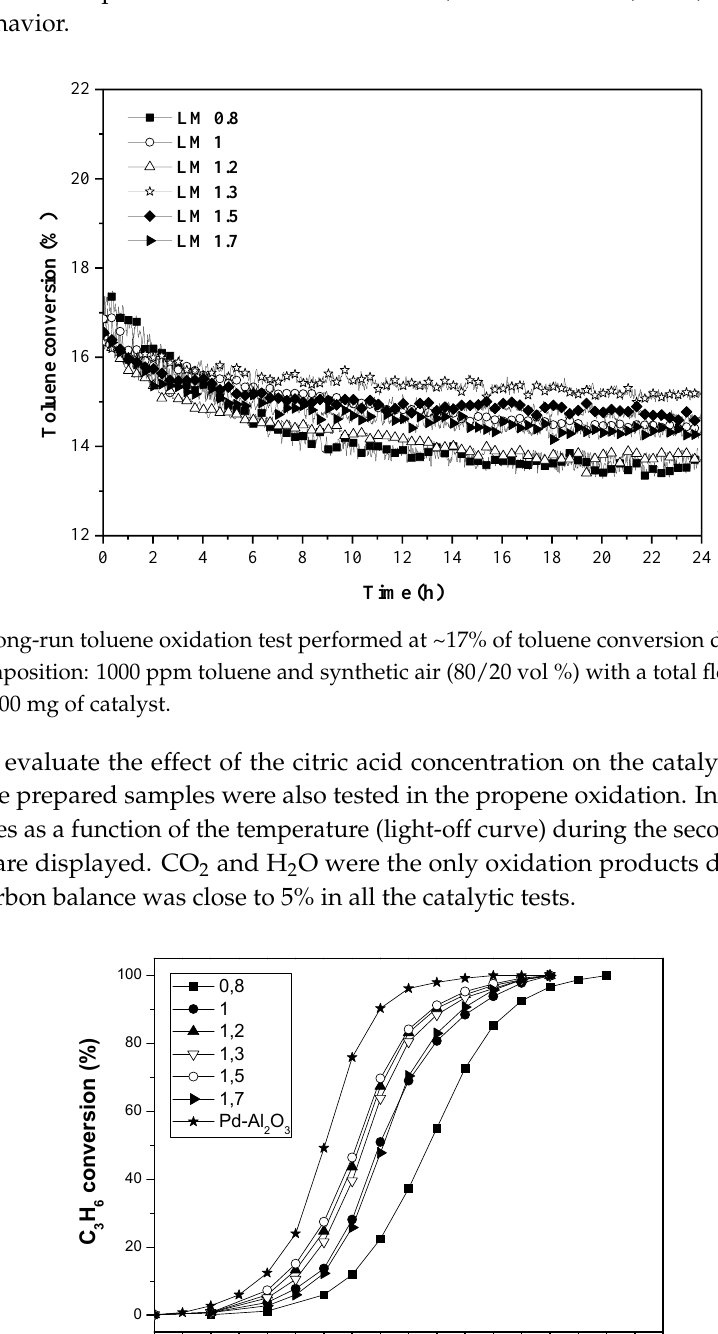
100 mL × min − 1 and 100 mg of and 100 mg of catalyst.